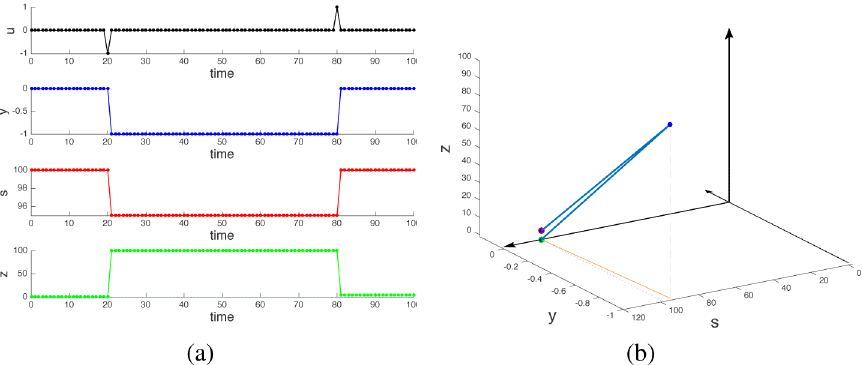
Fig 3. A sell-then-buy cycle. Panel (a): time profiles of the variables. Panel (b): shape and phase space profiles. Also in this case the trader obtains a profit from the cyclic operation (red dot in panel (b) is above the green dot), because the stock is bought at a lower price than it was